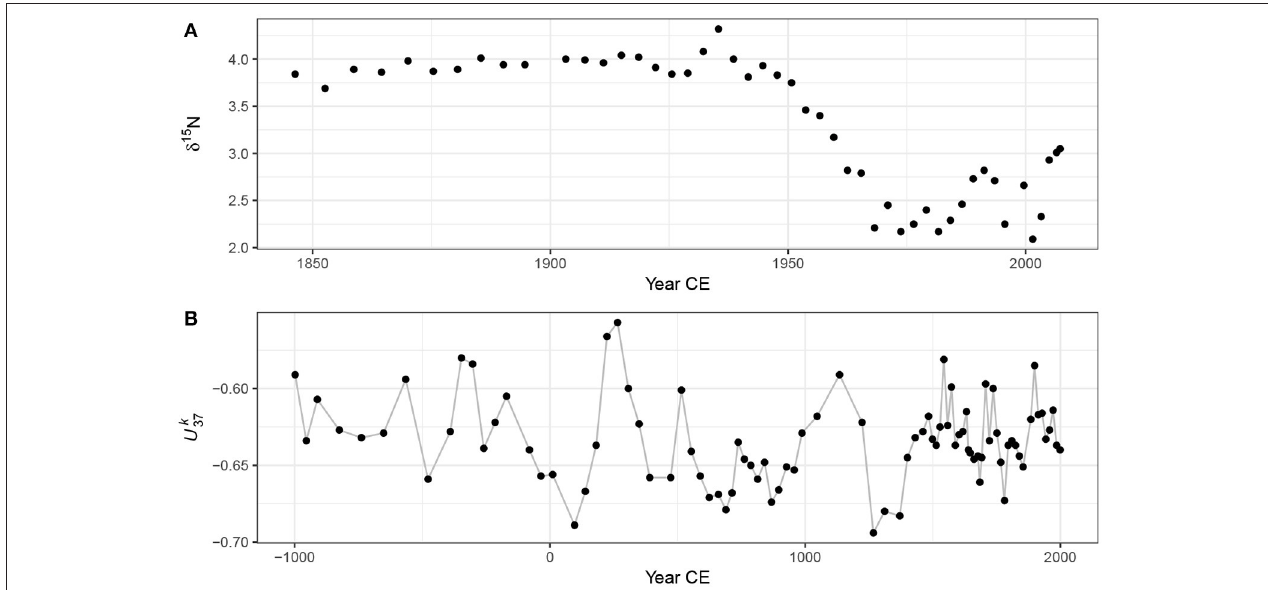
FIGURE 2 | Example time series; (A) Small Water bulk organic matter δ 15 N time series on a 210 Pb time scale, and (B) Braya-Sø U K 37 time series on a calibrated 14 C time scale. The observations in the U K 37 time series have been joined by lines purely as a visual aid to highlight potential